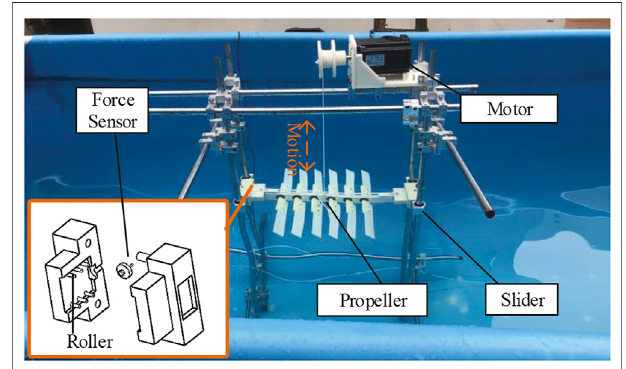
FIGURE 11 | Experiment framework: two heavy slider, a pressure sensor, several rollers in side the slider; all in a water pool with the water elevation about 1.3